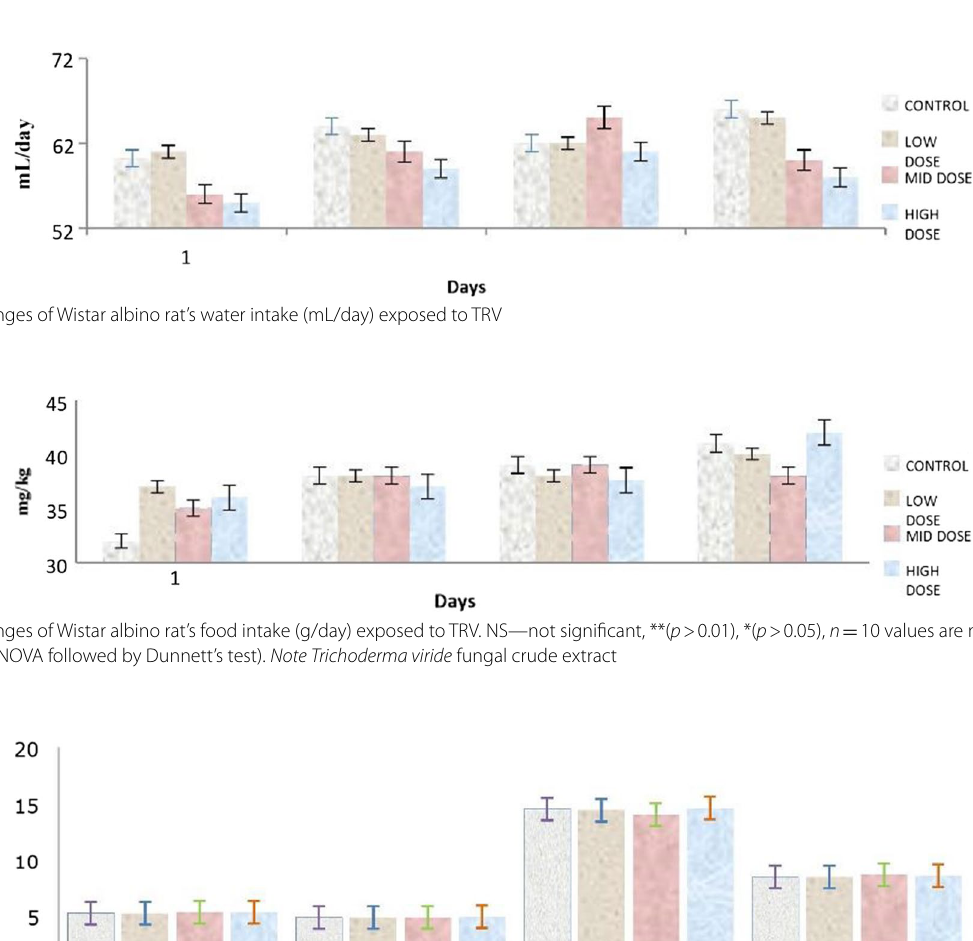
Fig. 8 Hematological observation of T. viride crude